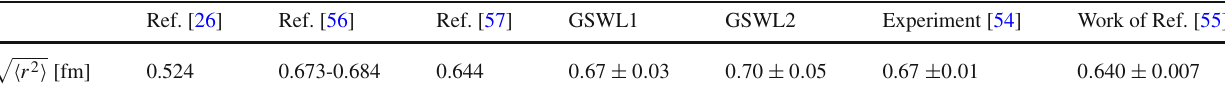
Table 2 Values of the pion mean radius obtained within different holographic models. Experimental data are from Ref. [54]. In the last column we report the recent analysis of Ref. [55] Ref. [26] Ref.